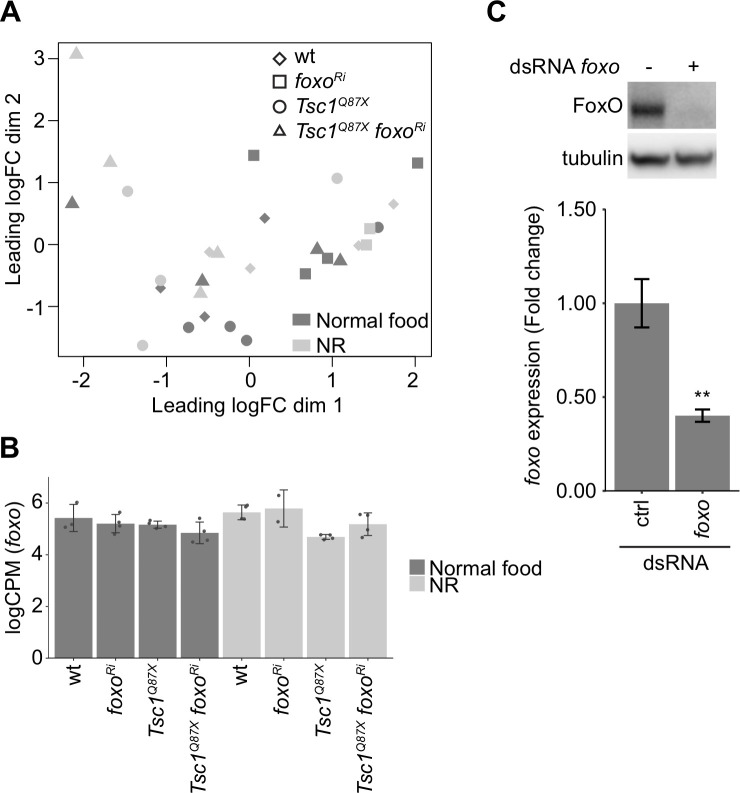
Validation of RNA-seq data.(A) Multidimensional scaling plot of log counts per million (CPM) of ctrl and Tsc1 mutant cells, with or without foxo knockdown, from different food conditions. (B) foxo expression levels in indicated conditions. Data are represented as mean ± SD. (C) Immunoblot and RT-qPCR analysis of Kc167 cells transfected with dsRNA against ctrl or foxo. n = 3. Data are represented as mean ± SD. **p<0.01.